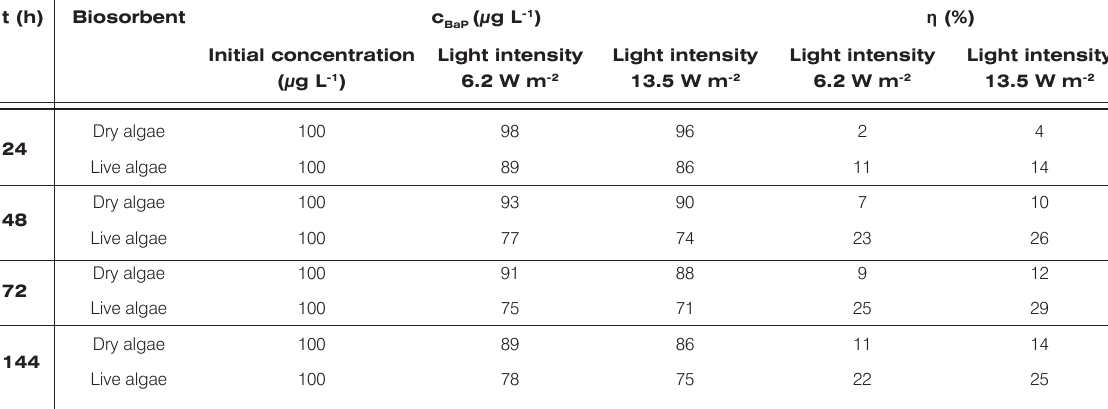
Table 1. Concentration of BaP after different biodegradation